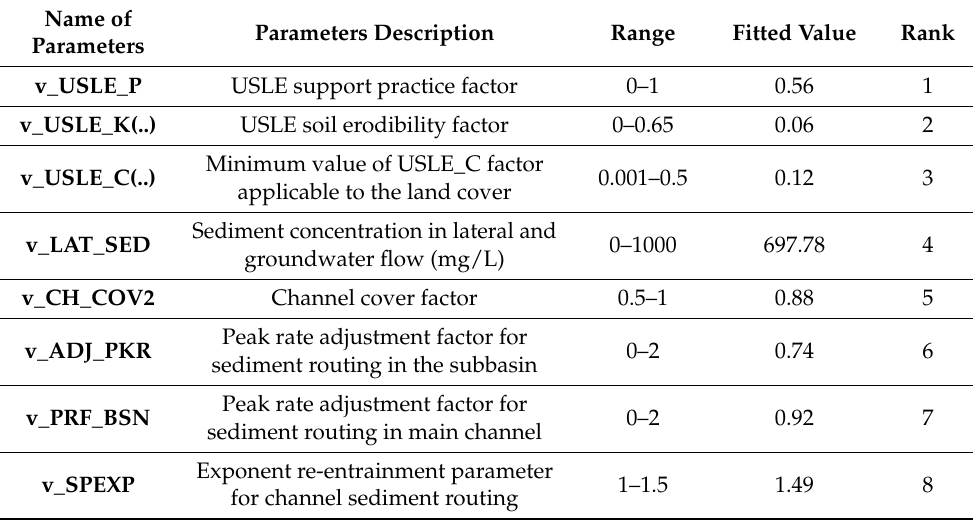
Table 7. List of parameters with parameter ranges, fitted values, and sensitivity rankings used for sediment calibration.